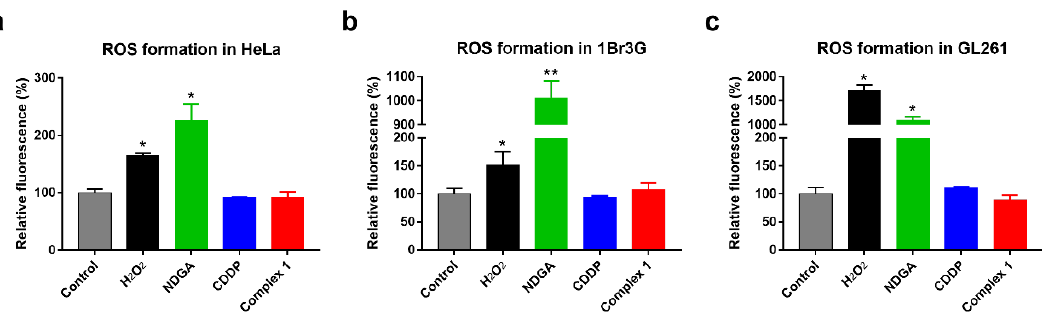
Figure 3. Reactive oxygen species (ROS) generation triggered in ( a ) HeLa, ( b ) 1Br3G and ( c ) GL261 cells. The concentration of H 2 O 2 was 0.1 mM, and other agents were used at their corresponding IC 50 . All data represent mean ± SE (standard error) of three independent experiments. * stands for p < 0.05, ** for p < 0.001.